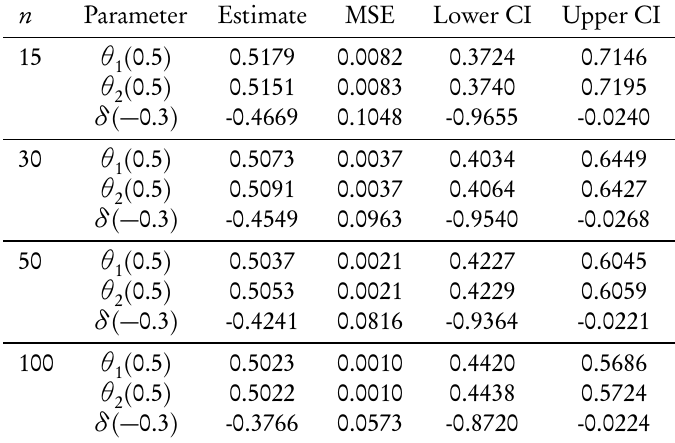
Simulation study of the parameters of BXG distribution (Case 1 -